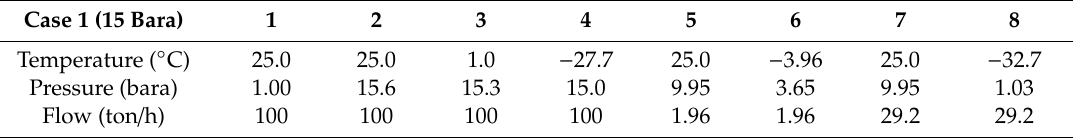
Table A7. Mass balance Case 3, 15 bara liquefaction pressure, stream numbering from Figure